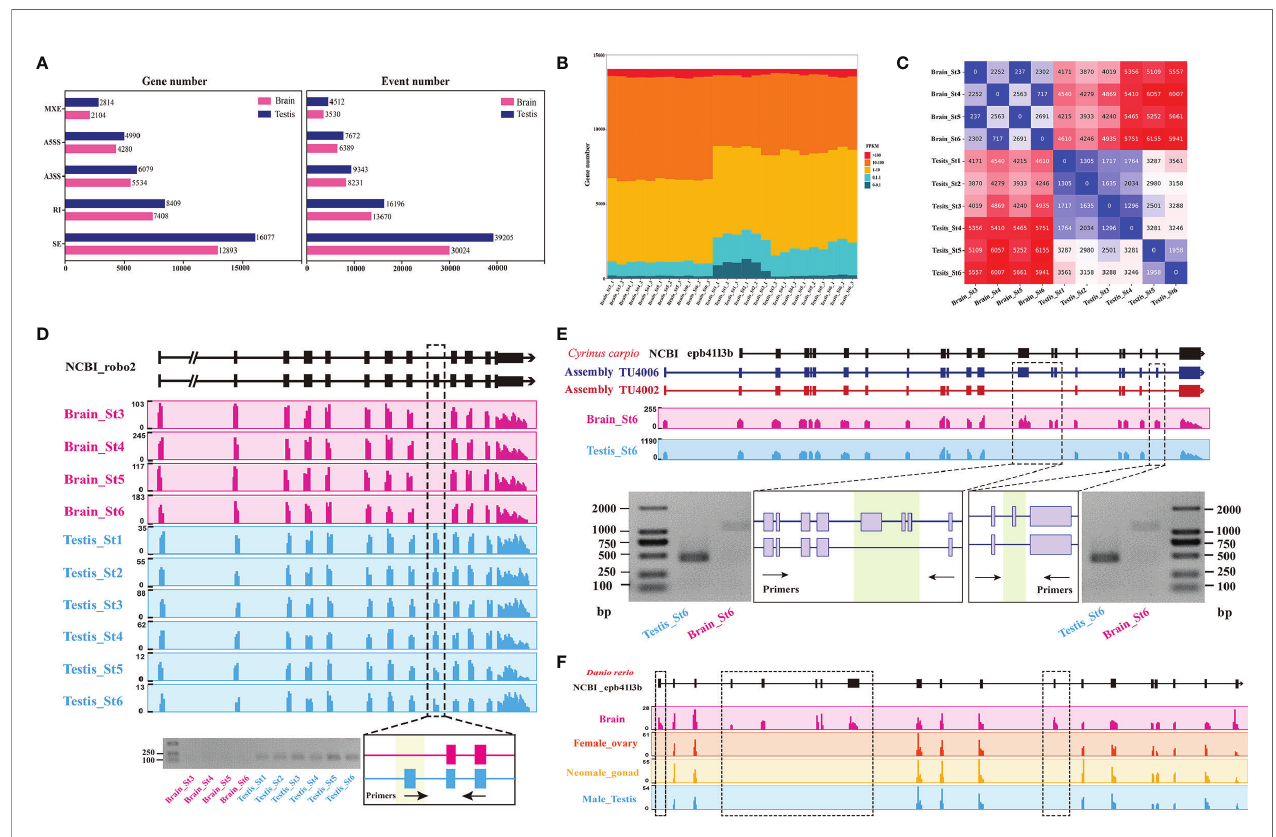
FIGURE 4 | Comparison of the alternative splicing (AS) patterns in the testes and the brain during gonad development of C. carpio . (A) Statistics of categories of AS events and associated genes identi fi ed in the gonad and the brain across time course. A3SS, alternative 3 ʹ splice site; A5SS, alternative 5 ʹ splice site; RI, intron retention; SE, exon skipping. (B) The FPKM expression levels of genes from SE events in the testes and brain at different stages based on RNA-seq. (C) Heatmap showing numbers of differential AS events between consecutive time points in either the brain or the gonad. (D) The case of the SE pattern of the robo2 gene and validation using RT-PCR in the testes and brain of C. carpio . The expressions of the robo2 exons are shown with sequence coverage depth on the gene loci. (E) The case of the SE pattern of epb41l3b gene and its validation using RT-PCR in testes and brain of C. carpio . The expressions of the epb41l3b exons are shown with sequence coverage depth on the gene loci. (F) The case of the SE pattern of the epb41l3b gene in the gonad and brain of Danio rerio